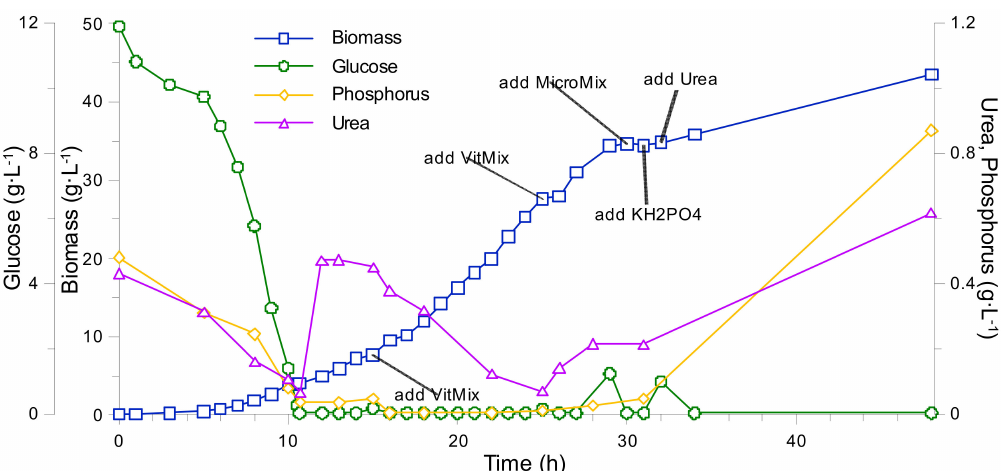
Figure A2. K. marxianus (MicroMix doped) bioreactor fed-batch cultivation. Tests of biomass growth response to vitamin and micro component mixture, and KH 2 PO 4 /urea solution addition. Growth media composition can be found in Table